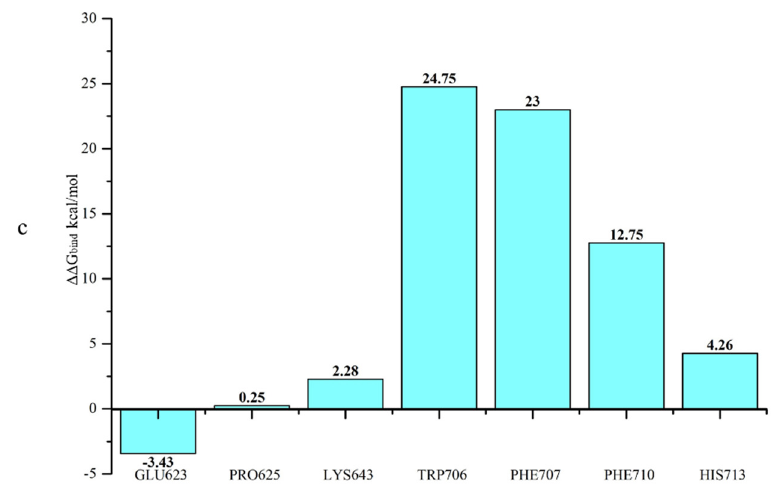
Figure 13. Alanine scanning mutagenesis analysis of ( a ) complex G07 − 3CM8, ( b ) complex G19 − 3CM8 and ( c ) complex G23 − 3CM8.